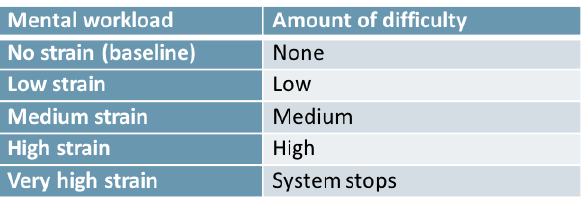
Table 9: Amount of diflculty related to mental workload.